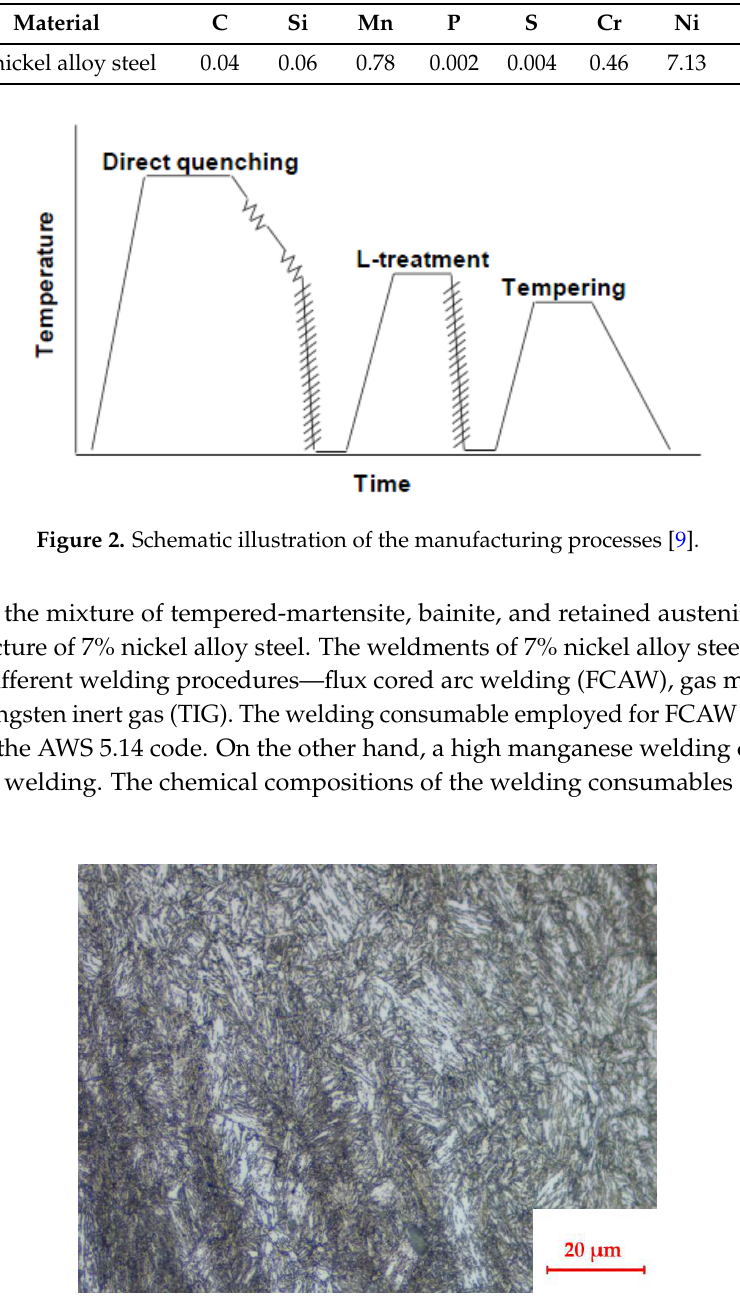
Figure 3. Microstructure of 7% nickel alloy steel. Table 3. The chemical composition of welding consumables [13].